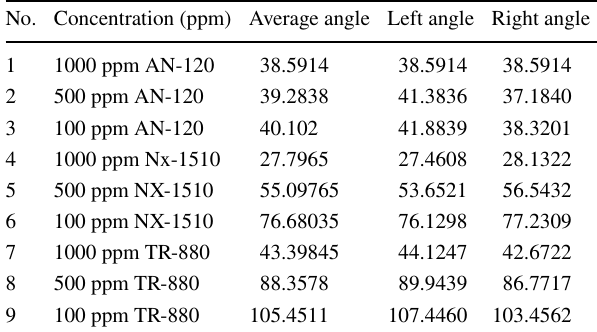
Table 7 Oil drop contact angle values for aged sections in AN-120, NX-1510 and TR-880 surfactant solutions at concentrations of 100, 500 and 1000 ppm after 3 days at 351.15 K and pressure of 14.7 psi No. Concentration (ppm) Average angle Left angle Right angle